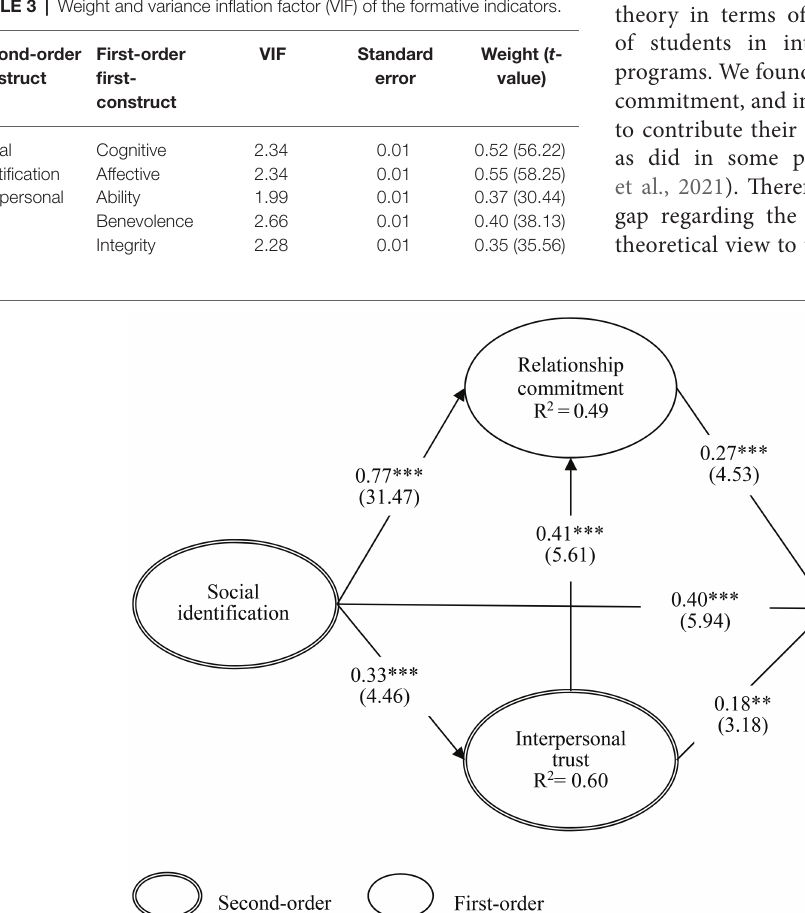
TABLE 3 | Weight and variance inflation factor (VIF) of the formative